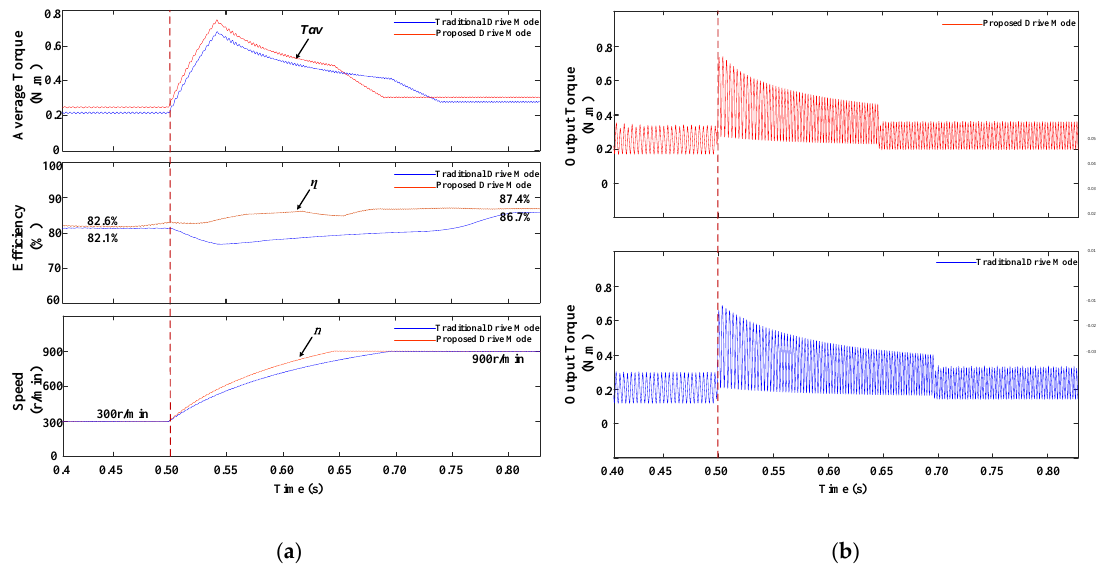
Figure 10. The dynamic performance of the SRM system when the speed is changed from 600 to 900 r/min. ( a ) Average torque and efficiency. ( b ) Output torque.